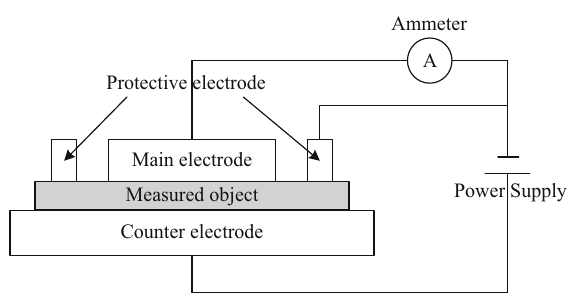
Figure 1: Principle of volume